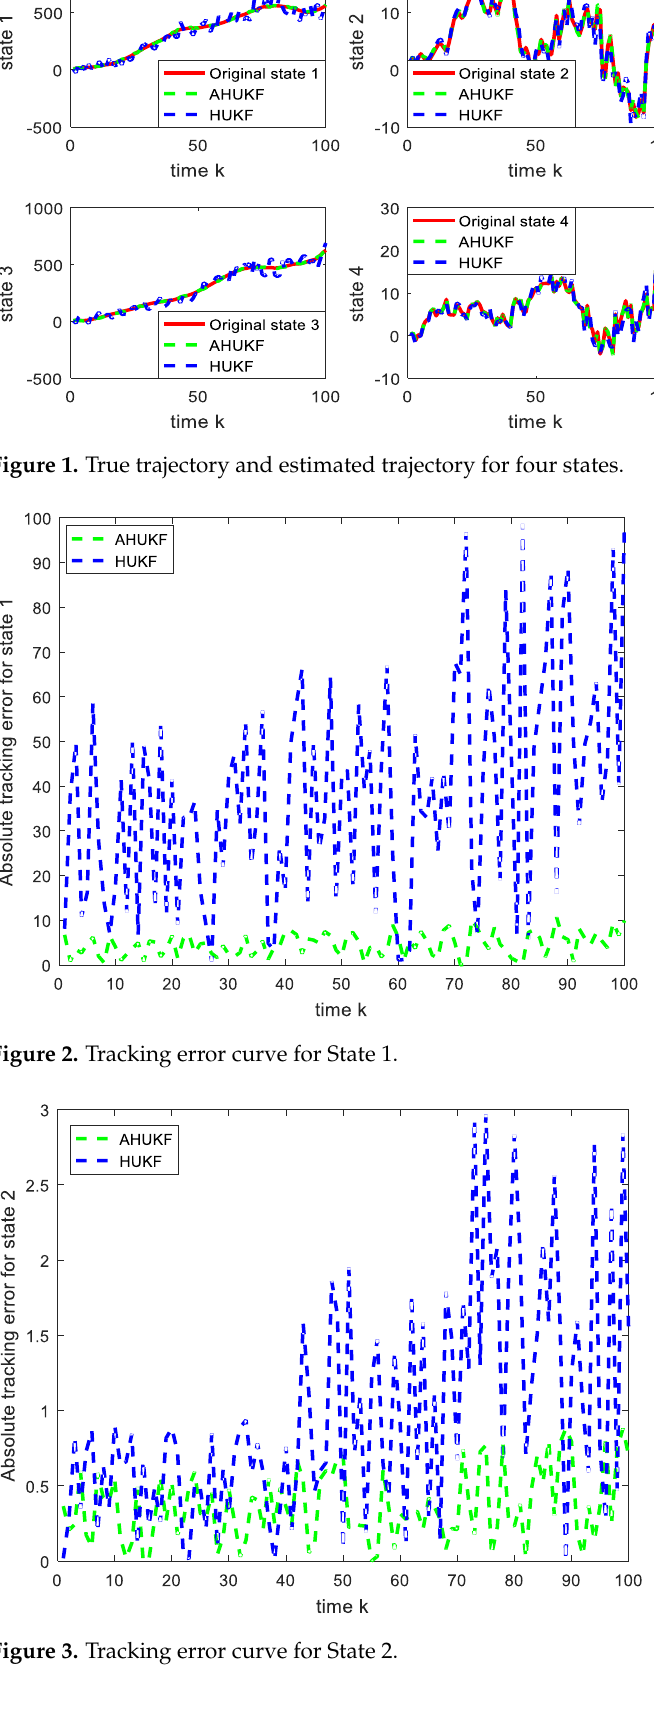
Figure 3. Tracking error curve for State 2.